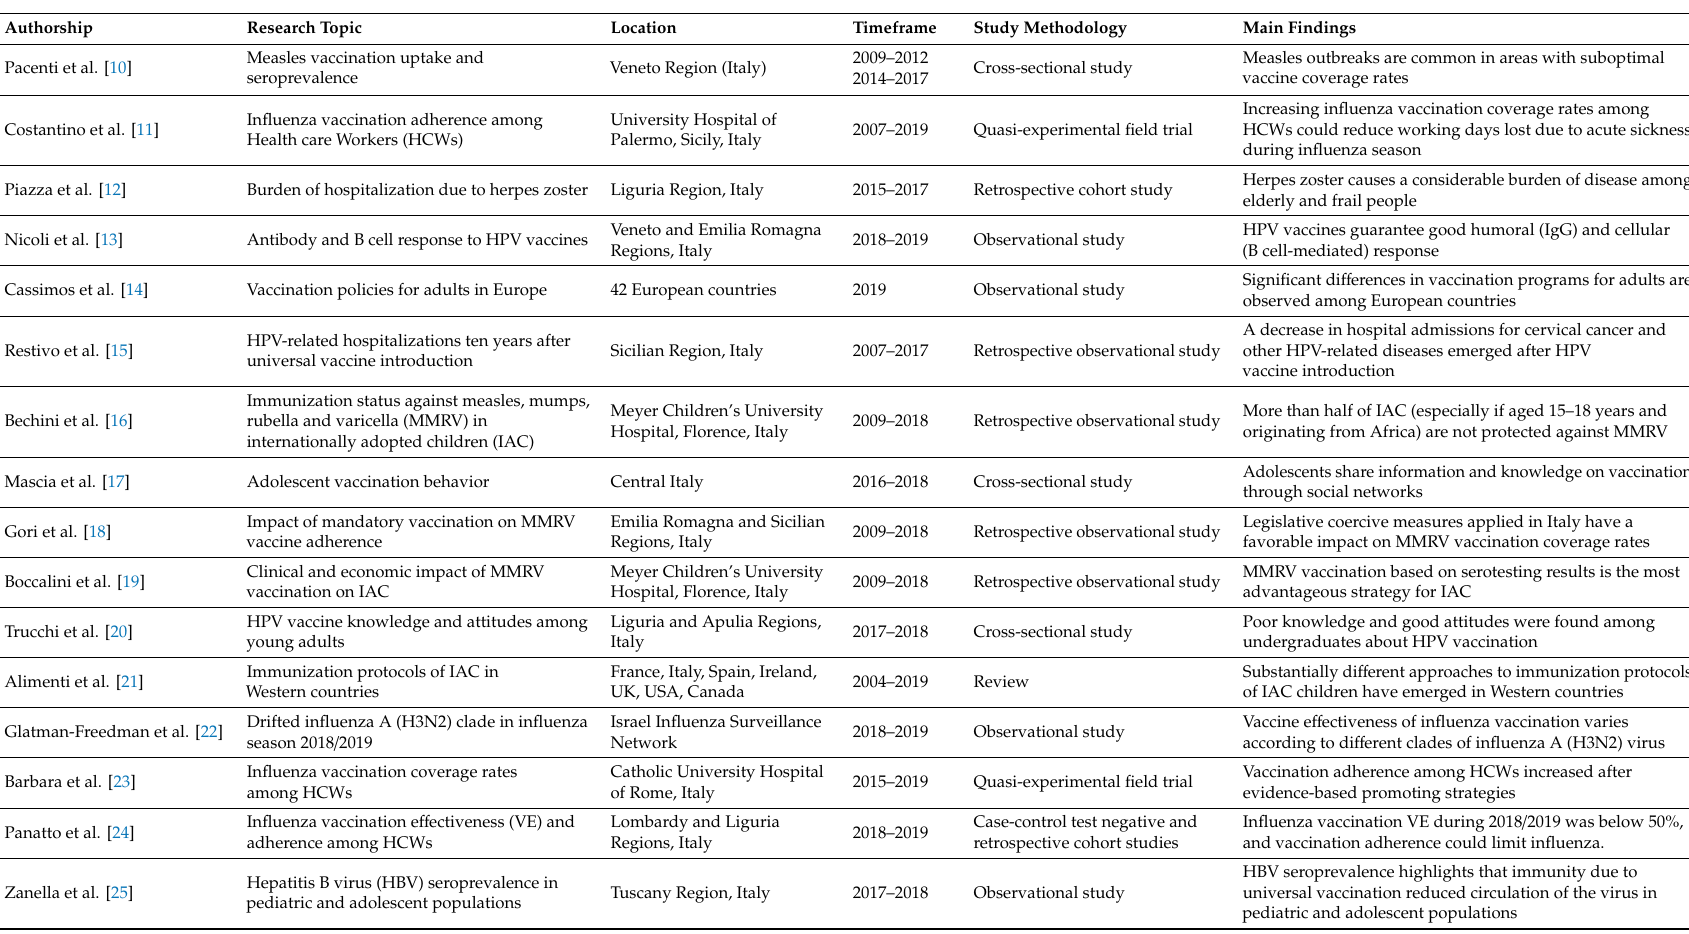
Table 1. Description of the manuscripts accepted for the Special Issue “Vaccination and Vaccine E ff ectiveness” in chronological publishing